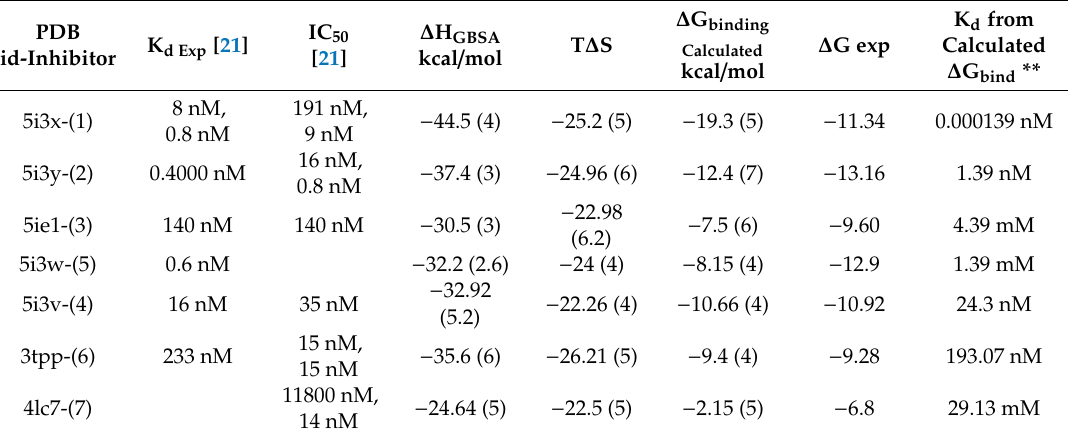
Table 1. The calculated energies of BACE1